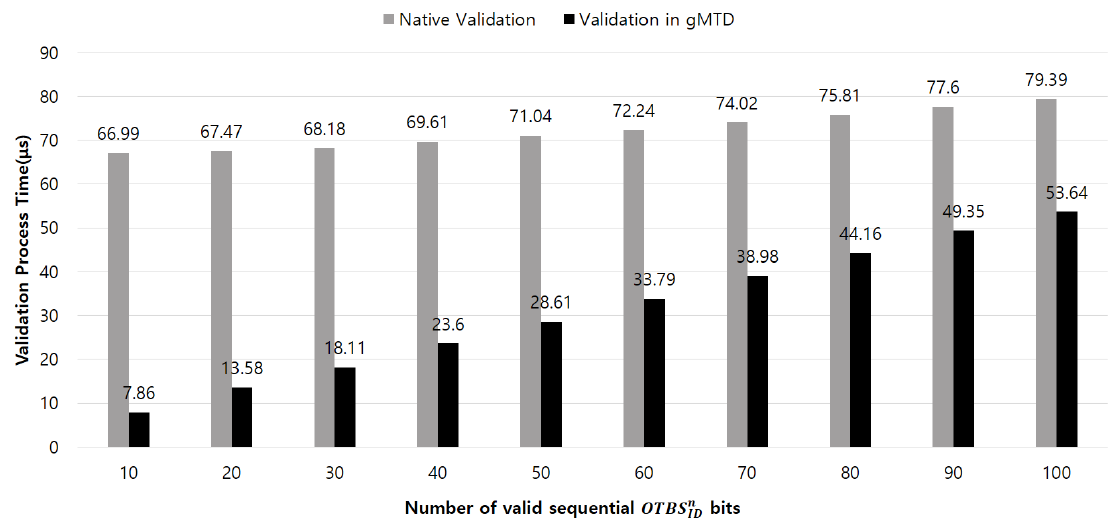
Figure 4. Measuring the validation process time with varying number of valid sequential OTBS n